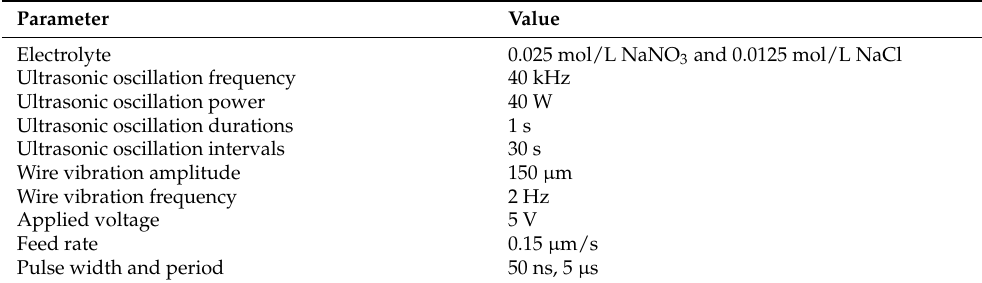
Table 3. The selected parameter combination for WECMM of pure aluminum rectangular mandrel.